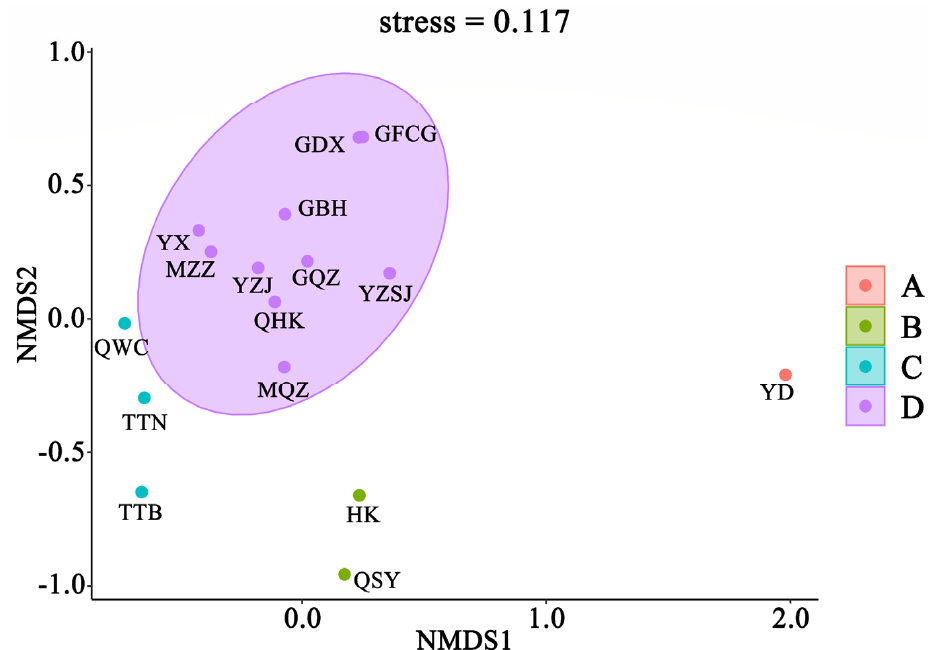
Figure 5. Nonparametric multivariate sequence of fish community structure in mangrove of China.